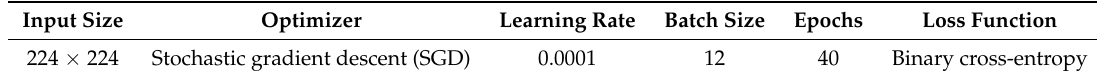
Table 2. Configuration for all